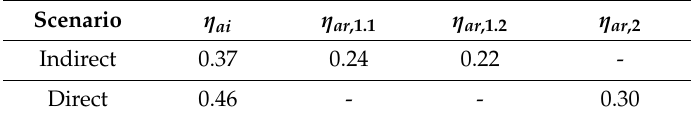
Table 3. Main figures of the indirect and direct pumping scenarios: efficiency index of ideal system ( η ai ), efficiency index of real indirect pumping system with energy recovery ( η ar ,1.2 ) and otherwise